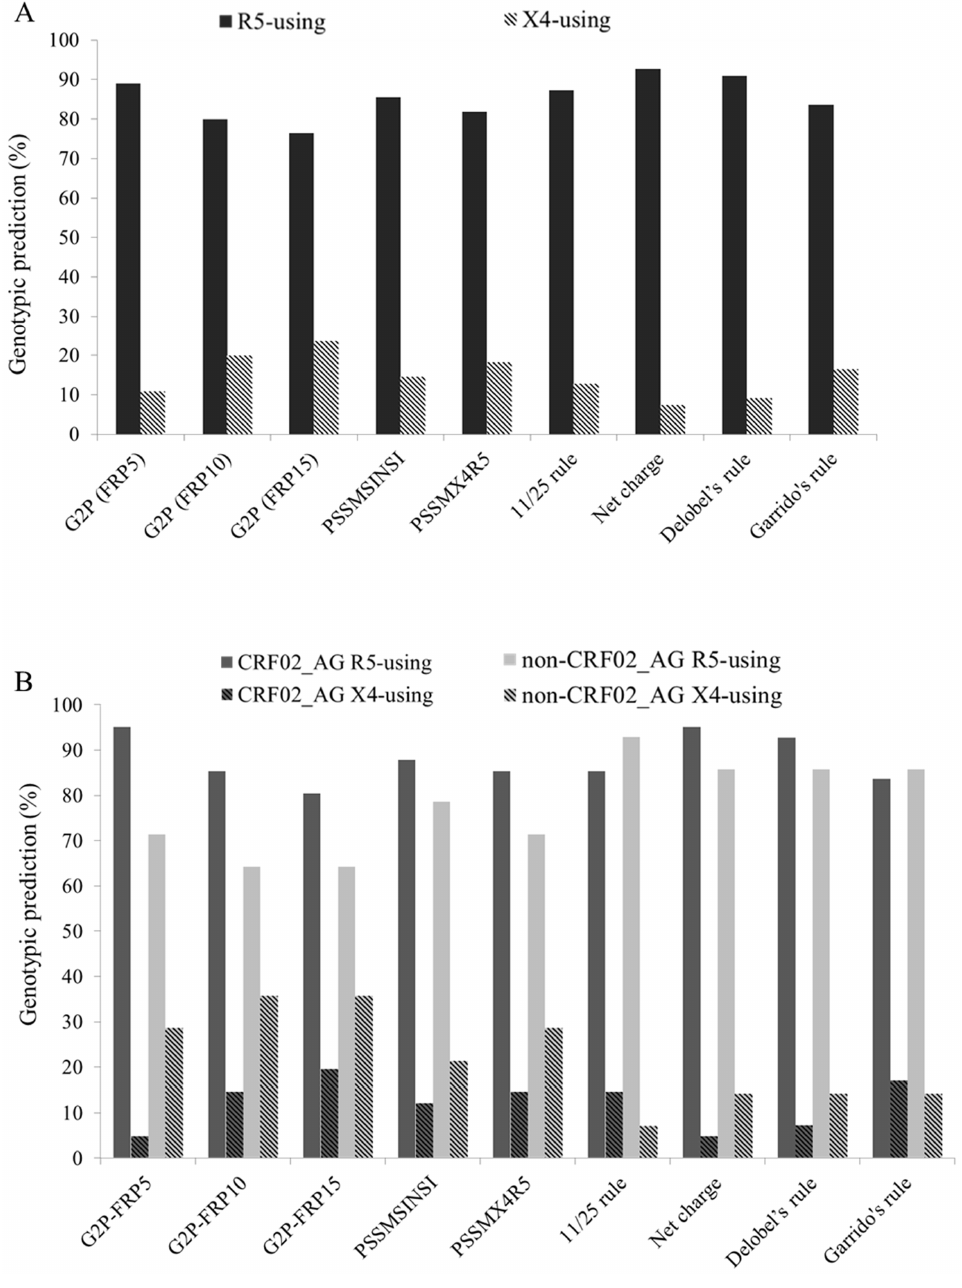
Figure 2. Prediction of HIV-1 co-receptor usage by using genotypic methods. (A) Prediction was assessed for the total number of samples. (B) Prediction was assessed in samples infected with HIV-1 subtype CRF02_AG or non-CRF02_AG strains.